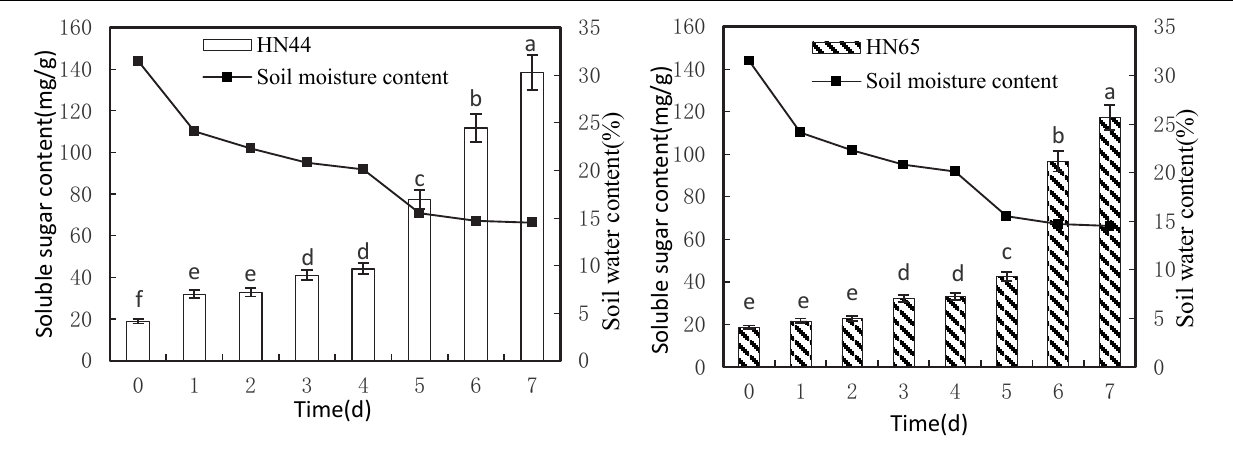
FIGURE 3 | Effect on soluble sugar content under different soil water contents. Indicates that the values marked with different letters are significantly different, and those marked with the same letter are considered to be statistically insignificant. TABLE 4 | Effect of drought on the relative growth rate of soluble sugar content (%).